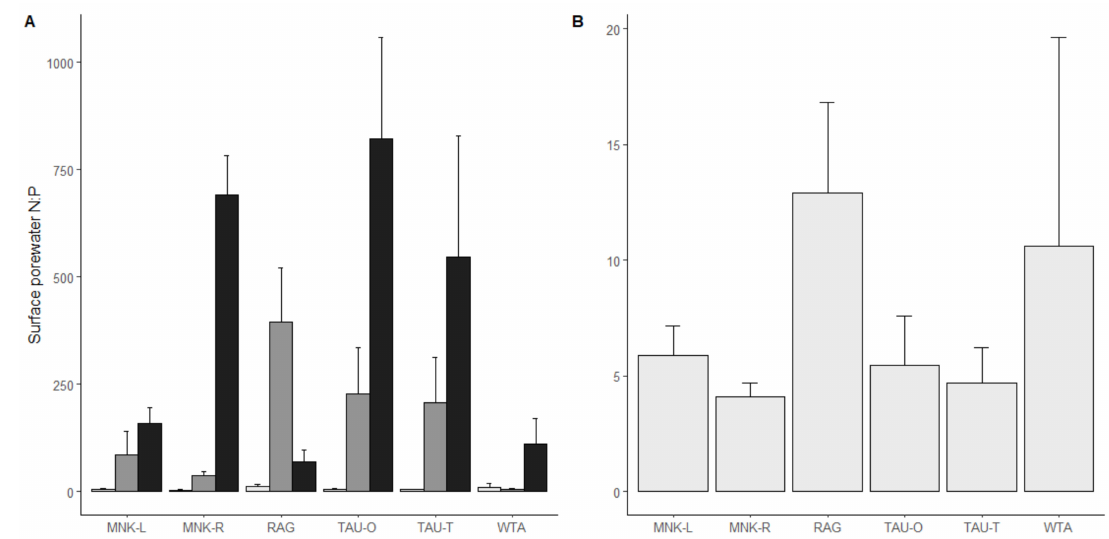
Figure A2. Surface (0–2 cm) porewater N:P ratios within ( A ) all sediment nutrient enrichment treatments (control = light grey, medium = dark grey, high = black) and ( B ) within control plots as a function of site (n = 6–9). Data are pooled across all sampling dates and standard error bars